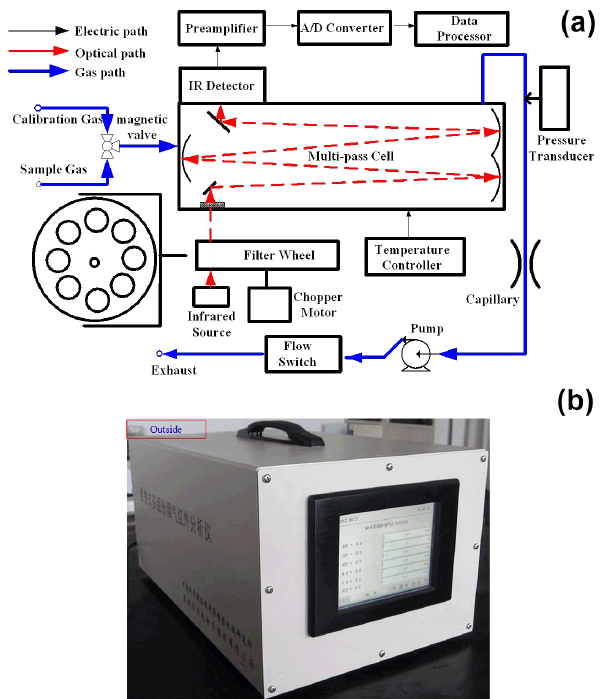
Figure 1. Layout of the experimental setup: (a) functional structure and (b) outside